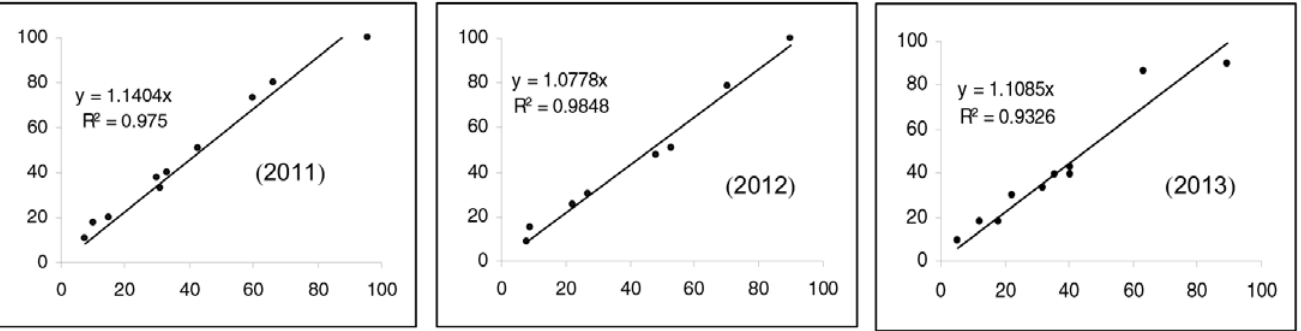
Fig. 1 - Relationship between incidence (I; proportion of diseased SCIs) and severity (S; proportion of SCI showing CRR symptoms) of wheat common root rot for three growing